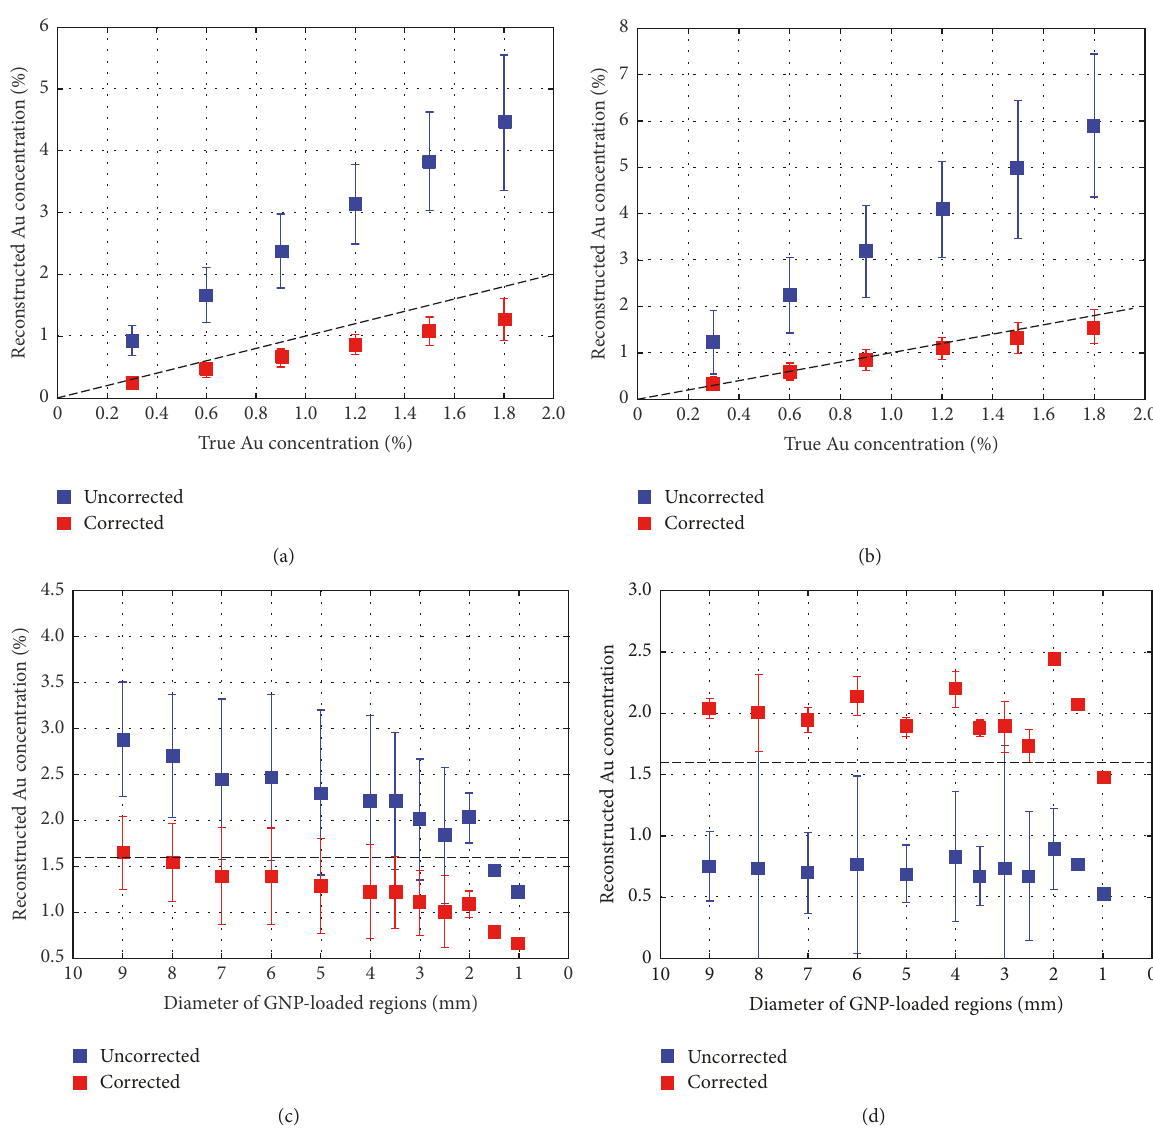
Figure 10: Reconstructed Au weight concentration. (a) and (c) Acquired by FBP algorithm with and without correction. (b) and (d) Acquired by MLEM algorithm with and without